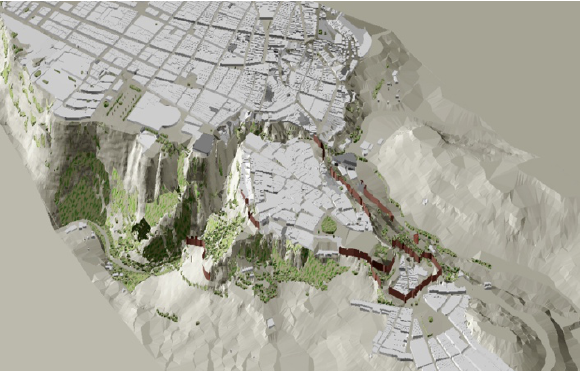
Figure 9. 3D view of Ronda. The importance of topography